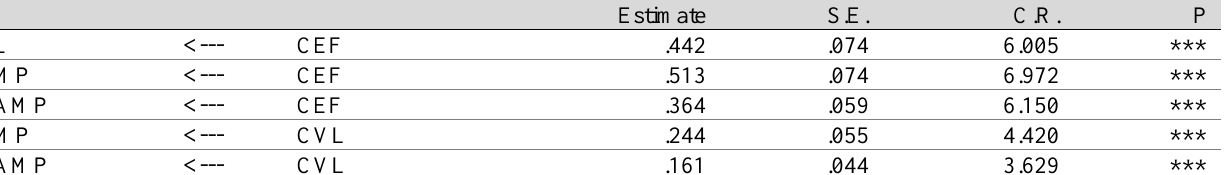
Structural Regression Analysis Results for Direct Paths